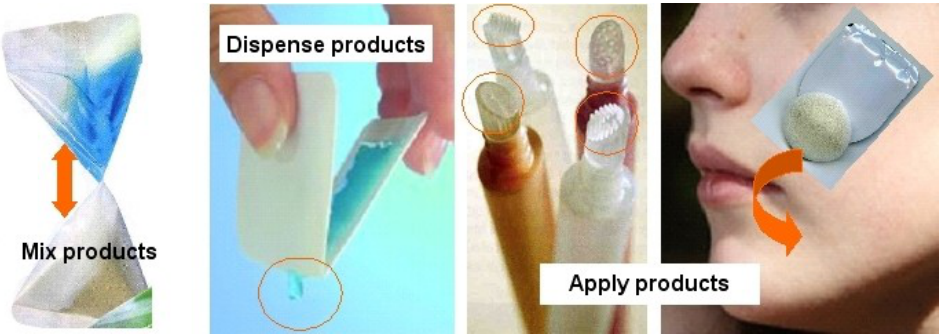
Figure 7. Example of single-dose dispensing systems for cream and gels